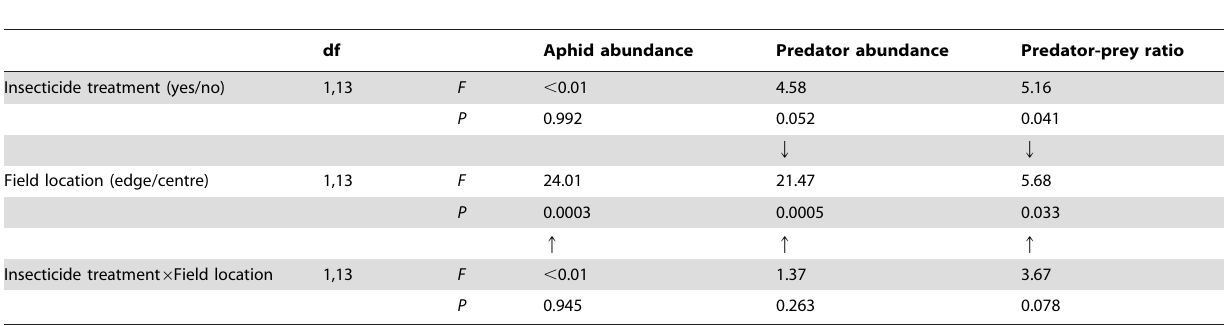
Table 4. Mixed effects model statistics for aphid abundance, predator abundance and predator-prey ratio with the explanatory variables insecticide treatment, field location and the interaction of insecticide treatment and field location.